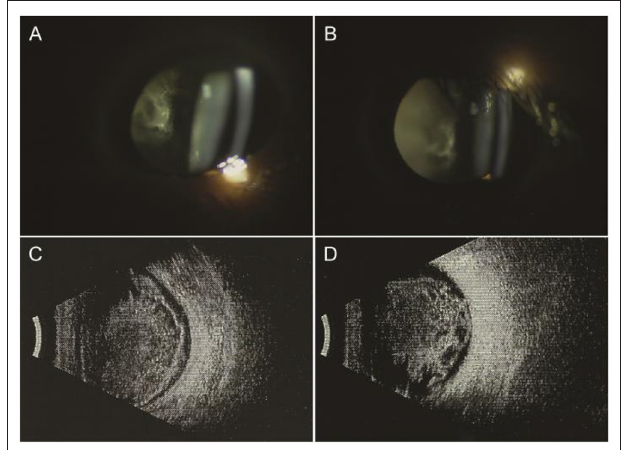
FIGURE 1 | Ophthalmic examination before the first operation. Anterior segment examination showed white vitreous opacities (footplates) adhering to the posterior lens capsule. B-scan ultrasonography revealed that the glass-wool vitreous opacities were almost completely detached except for the local adhesion to the retina and optic disc. (A,C) Right eye; (B,D) left eye.